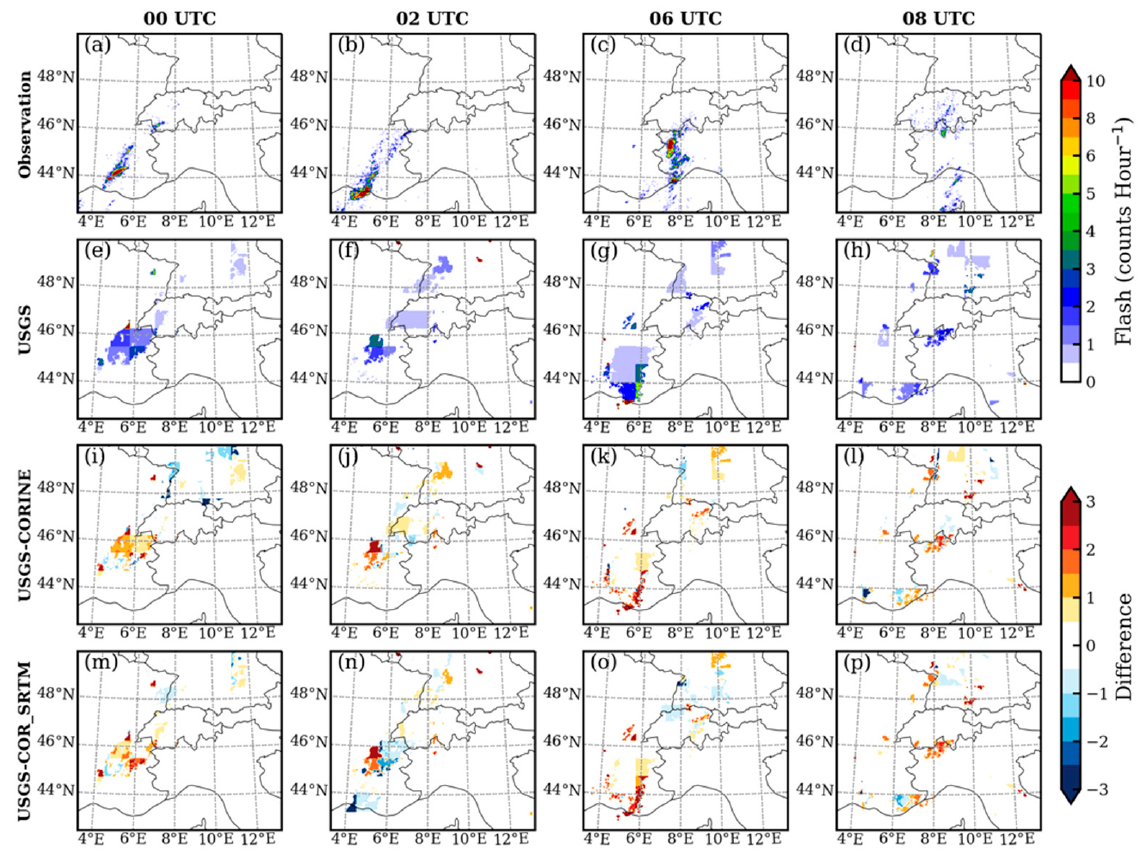
Figure 4. The distribution of lightning flashes based on ground-based observation (first row a – d ), USGS (second row e – h ), Corine (third row i – l ), Corine + SRTM (fourth row) ( m – p ) at different hours (0, 2, 6 and 8 UTC) on 29 July 2013. The differences between USGS, Corine and Corine + SRTM are shown in the third and fourth rows.